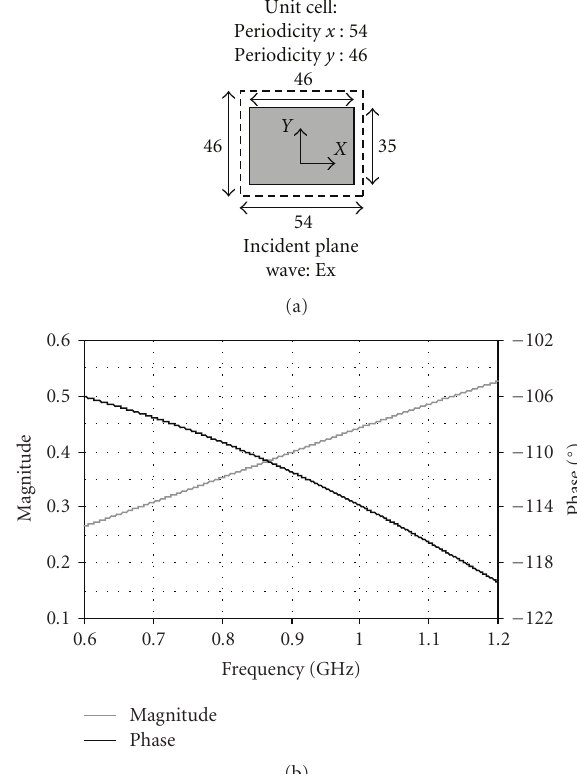
Figure 7: Reflection coe ffi cient of the